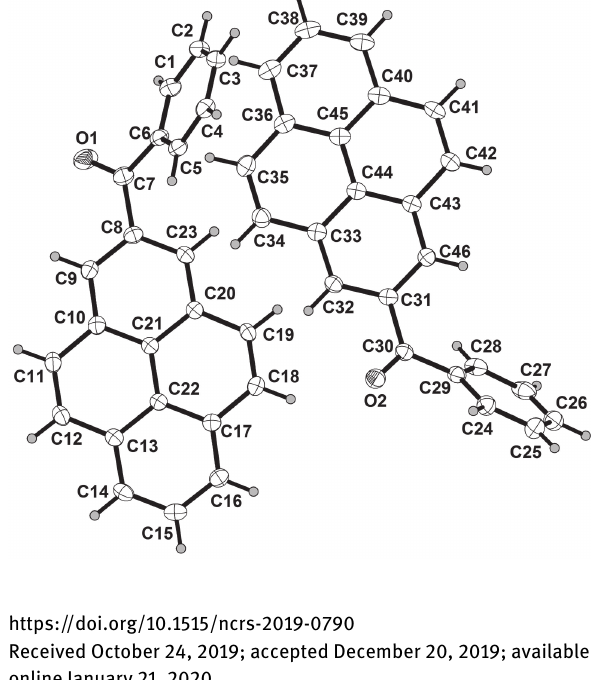
Table 1: Data collection and handling.